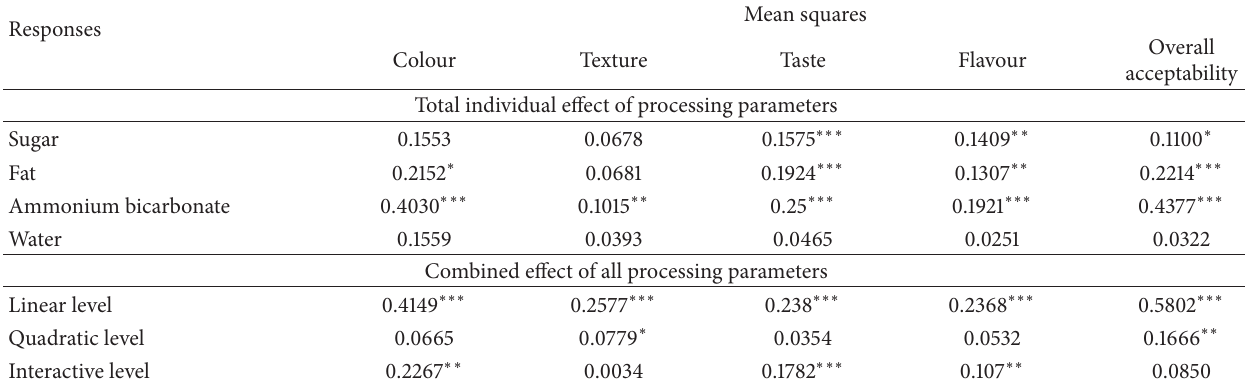
Table 3: ANOVA for the overall effect of processing parameters on the sensory responses a